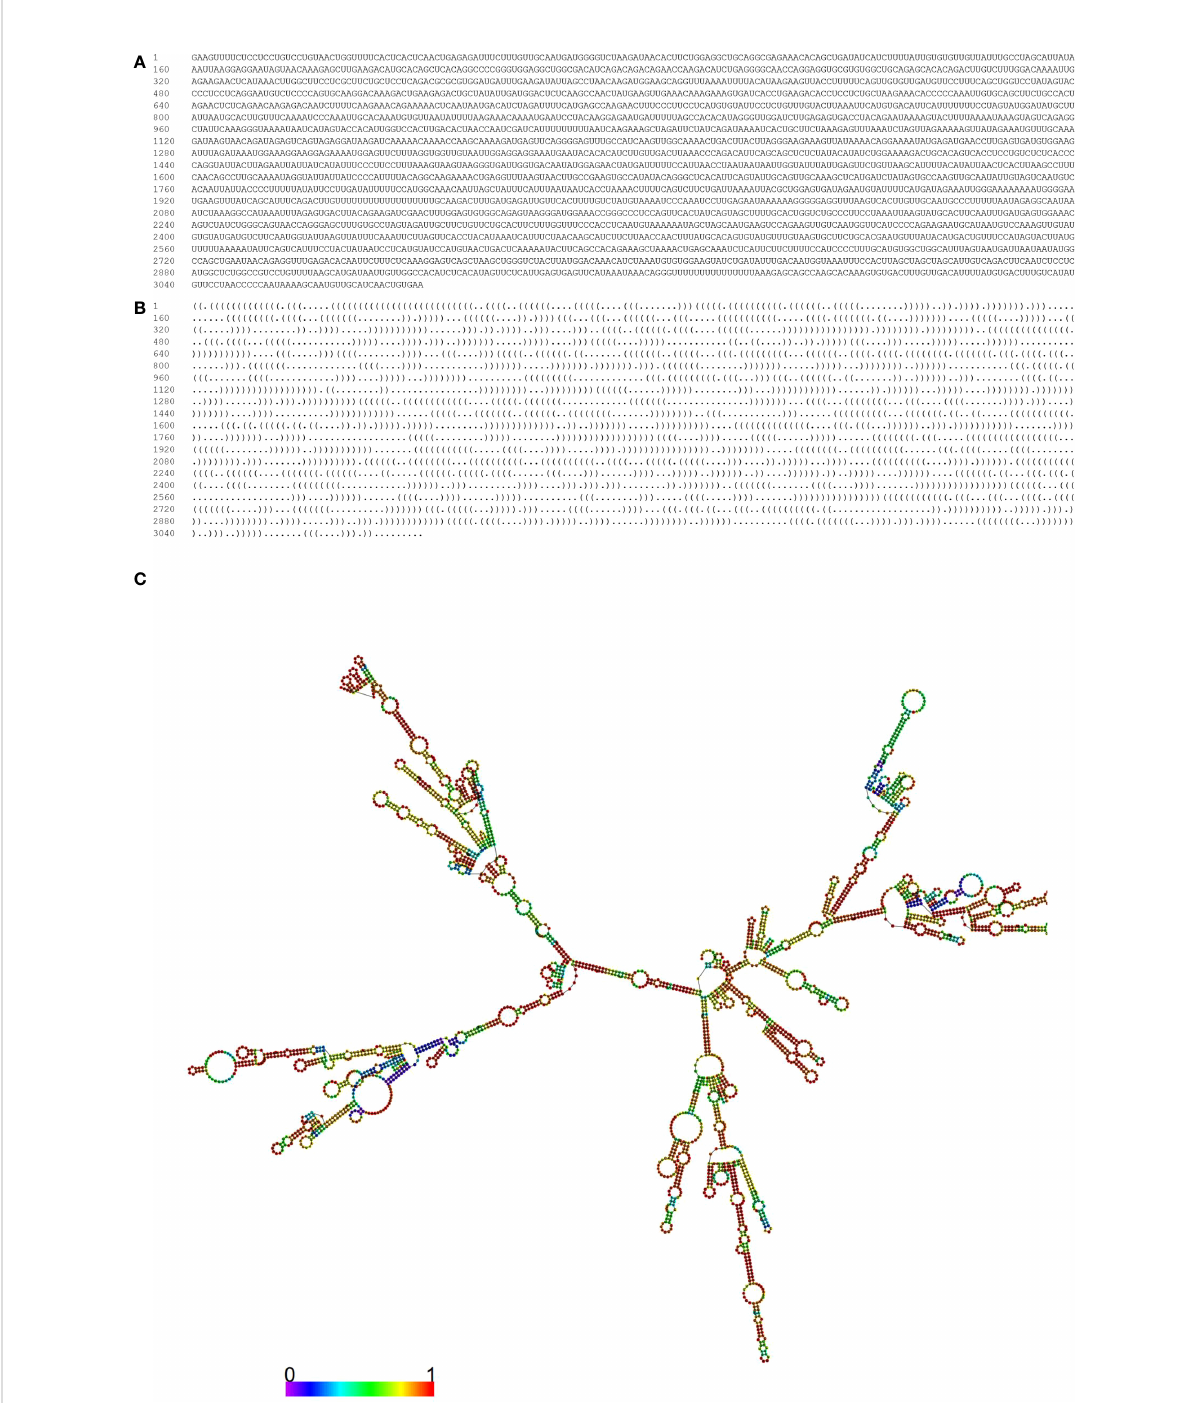
FIGURE 2 Optimal secondary structure of the MIR100HG. Prediction of the optimal secondary structure of the MIR100HG (Forena format) with-746.40 kcal/mol with its dot-bracket notation using the R-fold web server. (A) sequence; (B) dot – bracket notation; (C) the optimal secondary structure of the MIR100HG. In this structure, the color of the nucleotides is as follows: A, yellow; U, blue; C, green; G,